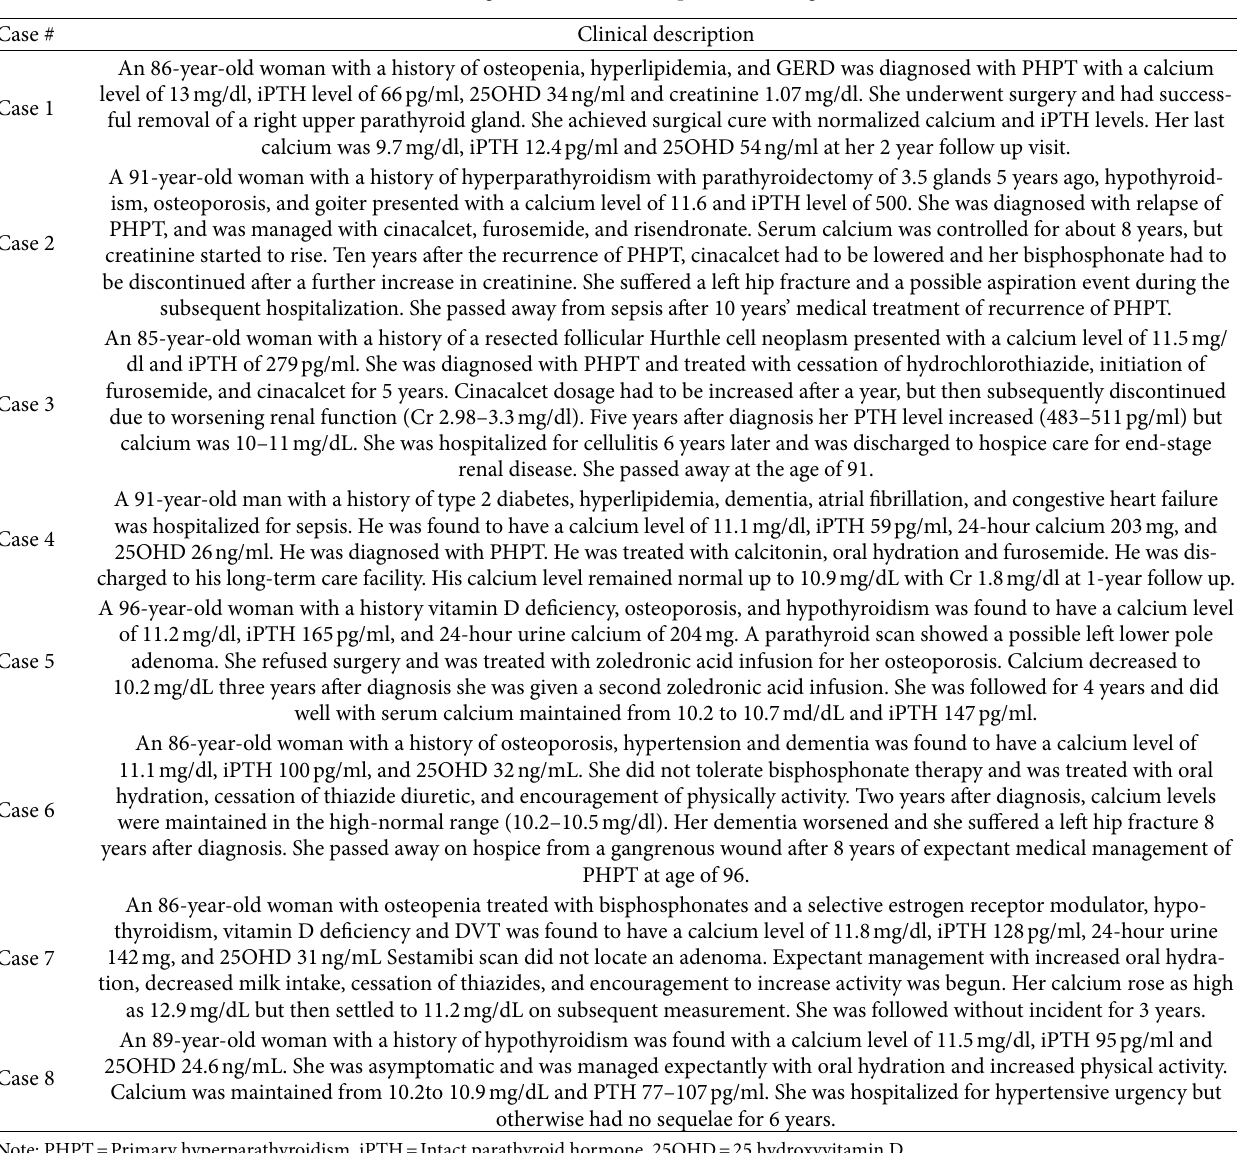
Table 1: Eight cases of PHPT in patients over age